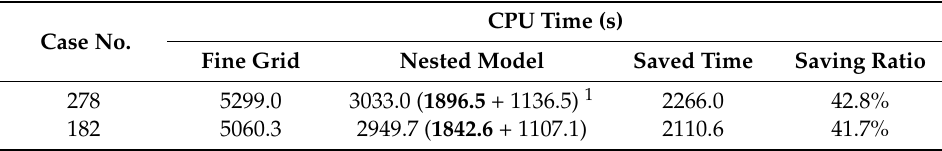
Table 1. Comparison of central processing unit (CPU) time required for the fine-grid/non-nested and for the nested